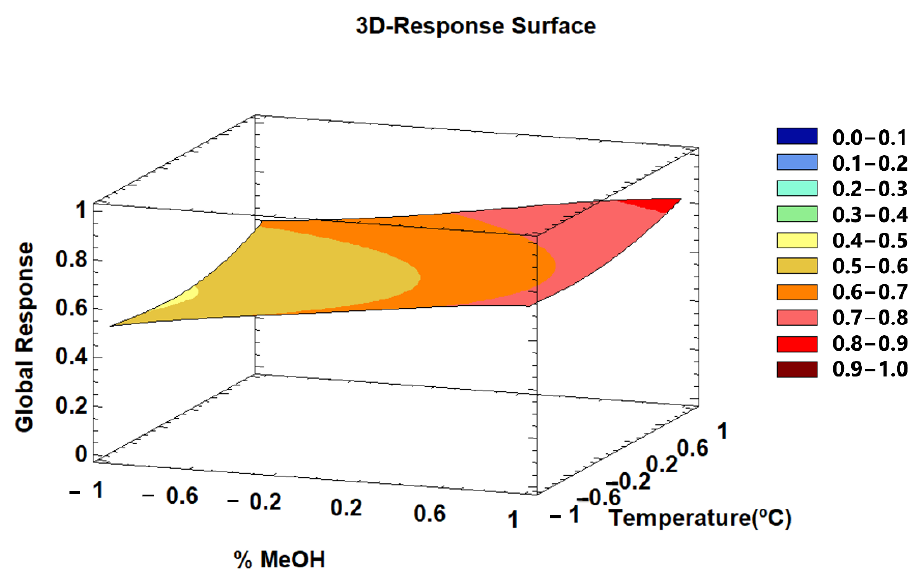
Figure 6. 3D – Response Surface graphic of the global response according to varying MeOH percent- ages in the extraction solvent and extraction temperature